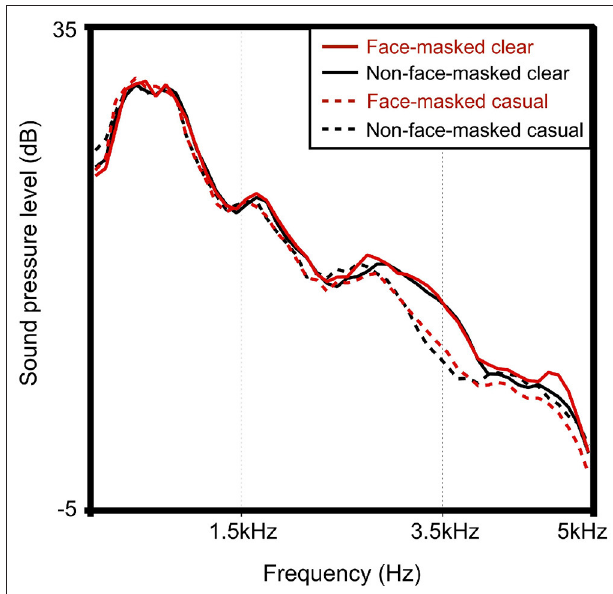
FIGURE 1 | (Color online) Long term average spectra (LTAS) of originally recorded sentences, by face-mask and speaking style condition. The y-axis shows relative sound pressure level (SPL) to 2e − 05 Pascal (the default in Praat). Note this is for sentences prior to the other pre-processing steps (e.g., normalizing intensity to an average of 60 dB and mixing with noise).